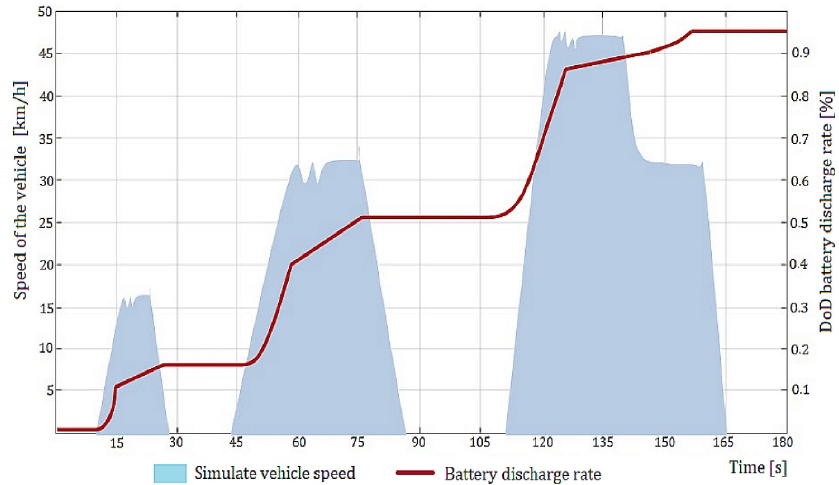
Figure 16. Plot of the battery discharge rate and speed of an electric car for a multi ‐ valued logic tree with the floor layout of decision variables of: X 3 , X 5 , X 1 , X 2 , X 4 . The developed simulation study in the expert system can be modified by entering new computational formulas into the spreadsheet (or Matlab) or removing redundant ones. In particular, different variants of the driver’s behavior can be analyzed by using a multi ‐ valued logic tree algorithm. Depending on the needs, it is possible to plot the dif ‐ ferent quantities calculated in the expert system. It is advisable to perform simulations for a real vehicle with fully detailed technical characteristics of the drivetrain, the engine, and the power supply battery, and to compare them with the measurement results obtained in road or bench tests. In future works, the authors will simulate the car driving in urban driving and high ‐ way driving cycles considering the possibility of braking energy recuperation. 6. Conclusions The paper presents the concept of building an expert system for the decision support of an electric car driver in minimizing the energy consumption of an electric car’s move ‐ ment. The controller block simulates the driver’s actions by controlling the accelerator pe ‐ dal. Depending on the position or depth of depressing the pedal, a specific torque of the electric motor is generated, which influences the momentary travelling speed of the vehi ‐ cle. The driving style and behavior of the driver (nervous/calm) and the average speed achieved are very important for the driving range. In addition, the influence of the ambi ‐ ent temperature on the efficiency of the vehicle and ultimately on energy consumption must be considered. All driving combinations in the driver–vehicle–environment system can be recorded by the decision support system. Decisions can be made in different di ‐ mensions (temporal, spatial) and situations (in specific sets of external and internal con ‐ ditions). The application of the system should provide prompts to the driver (how to react by acting on the accelerator and brake pedal) as quickly as possible, and who should also obtain them in real time (which may be a prerequisite for some information). However, such analysis requires a wider implementation of the built system. The methodology for designing and implementing integrated decision support systems is described primarily in the area of software engineering, which is the practical application of energy manage ‐ ment in electric cars.